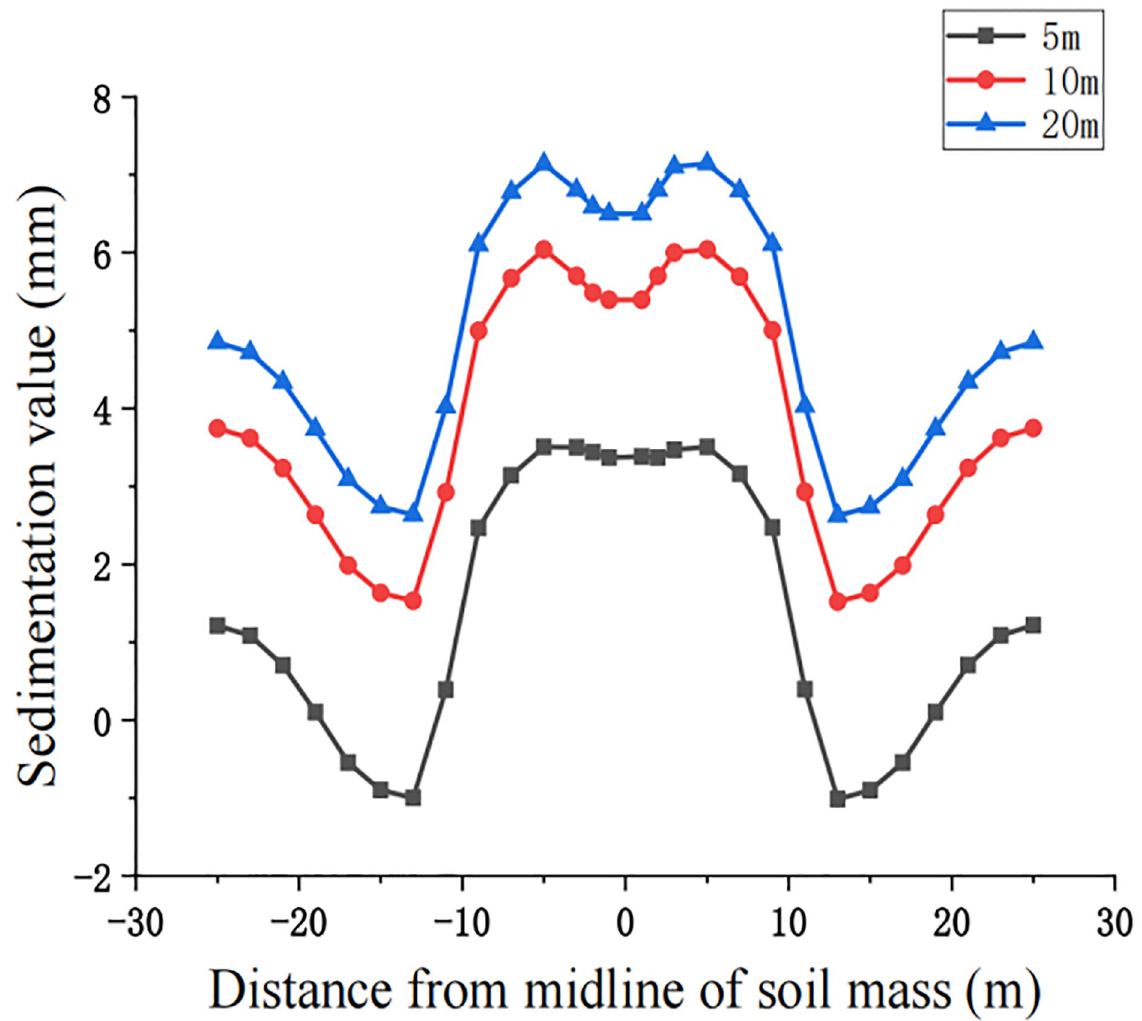
Fig 16. Surface deformation curves for three working conditions of powder